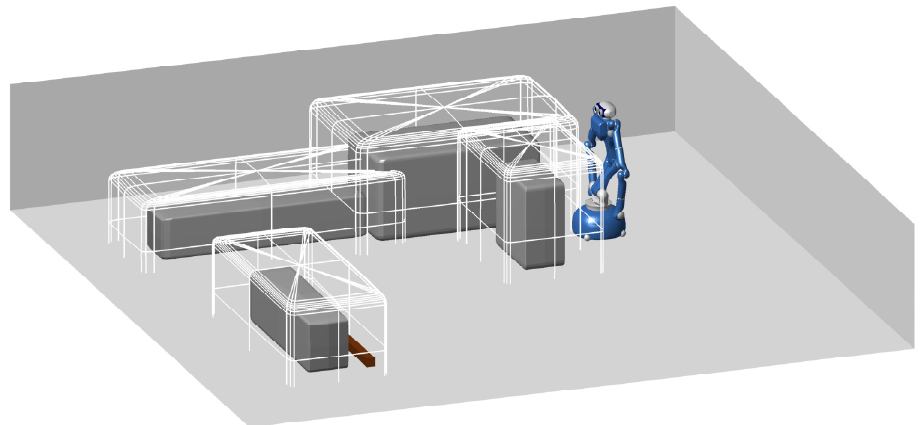
Figure 4. Model of the scene for the purposes of avoiding collisions.